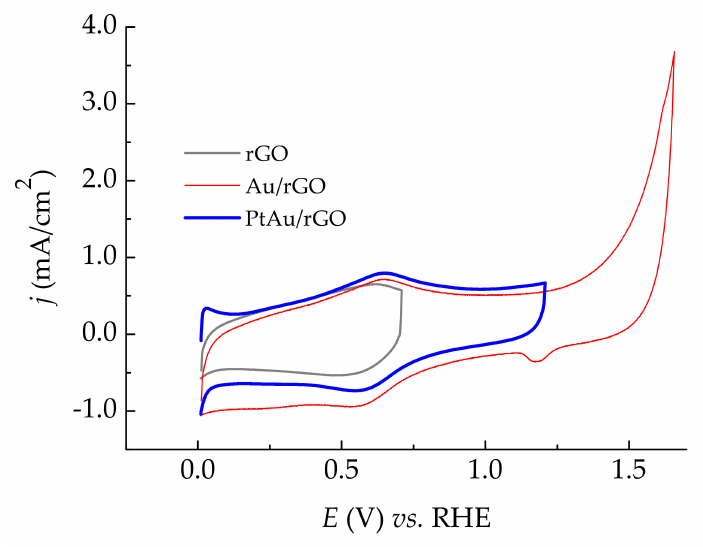
Figure 5. Cyclic voltammograms of rGO, Au/rGO, and PtAu/rGO. The scan rate was 50 mV/s.